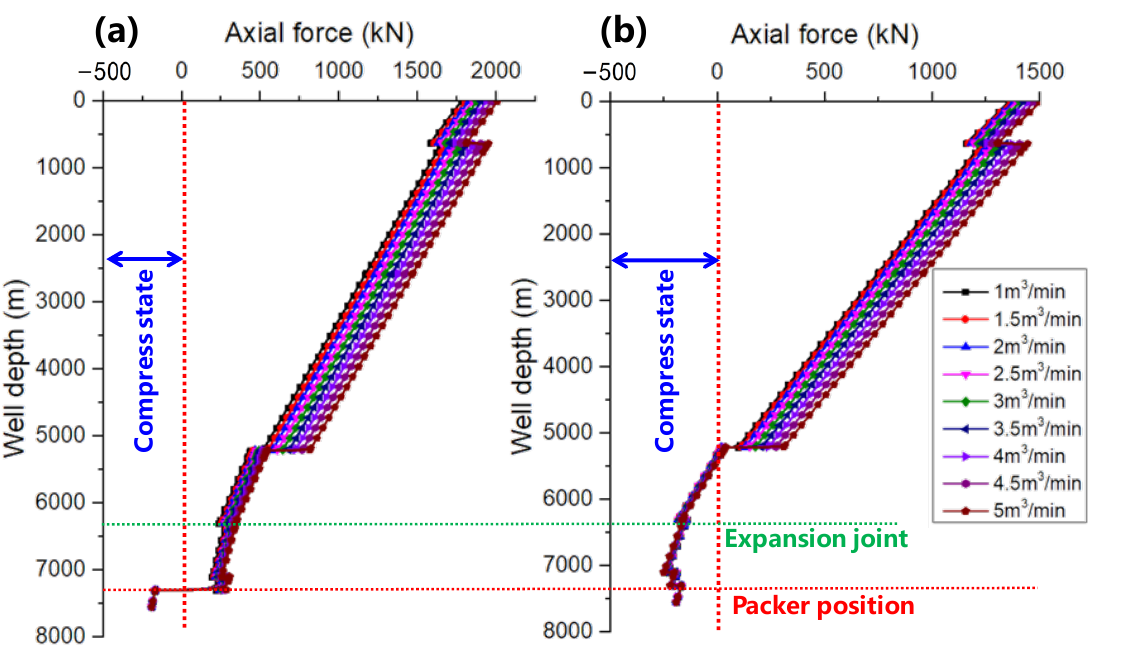
Figure 11. Axial force of the two kinds of tubing string under different injection rates vs. well depth: ( a ) tubing string without expansion joint and ( b ) tubing string with expansion joint.